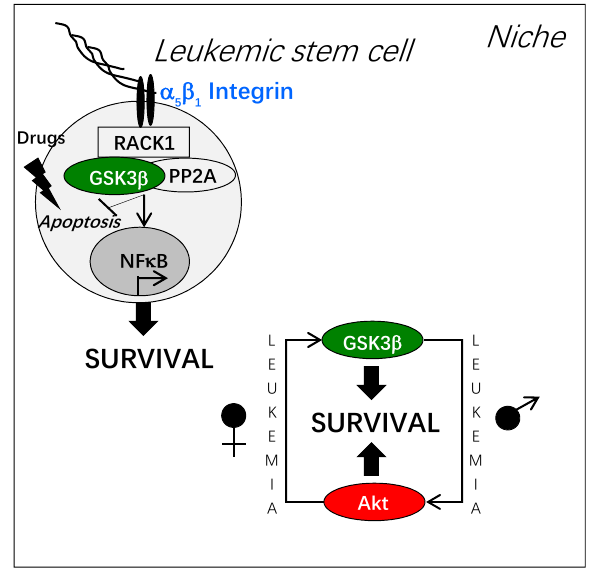
Figure 3. Integrin ‐ dependent activation of GSK3  and leukemic stem cell resistance. Adhesion of Figure 3. Integrin-dependent activation of GSK3 β and leukemic stem cell resistance. Adhesion leukemic stem cells to fibronectin or to osteoblasts triggers the formation of a molecular complex